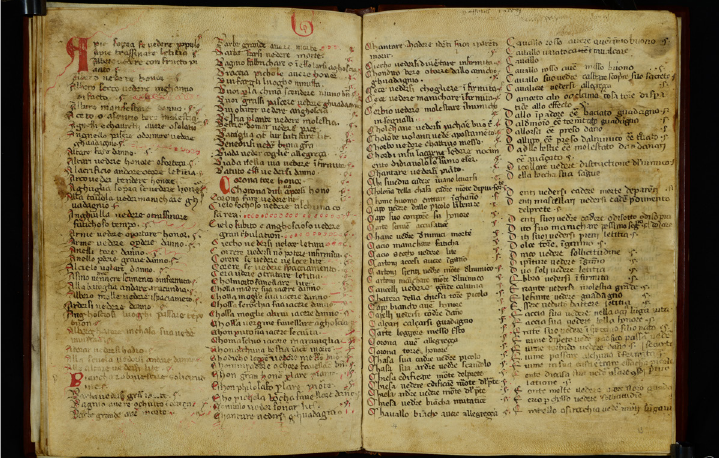
Fig. 1: Florence, The Biblioteca Medicea Laurenziana, MS Martelli 12, fol. 32v–33r. Reproduced with permission of MiBACT. Further reproduction by any means is